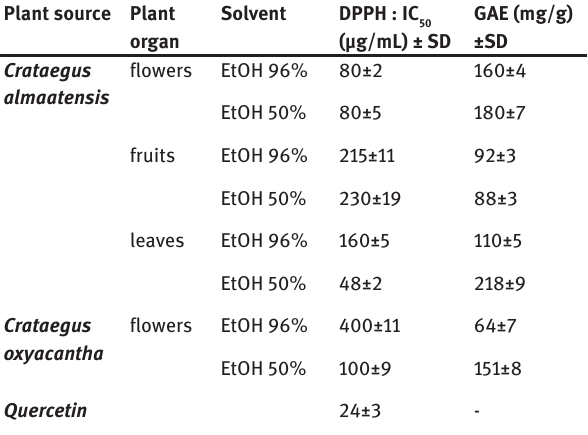
Table 5: The results of antioxidant study and total phenolic content determination on the extracts prepared from Crataegus almaatensis and Crataegus oxyacantha. ( SD – standard deviation